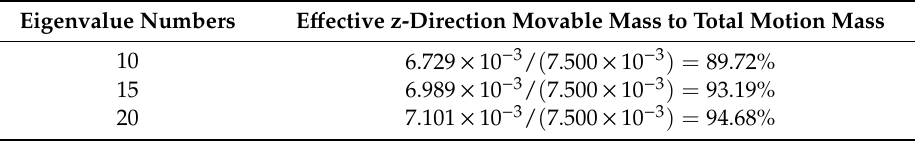
Table 5. Ratios of z-direction mass to total mass under di ff erent eigenvalue